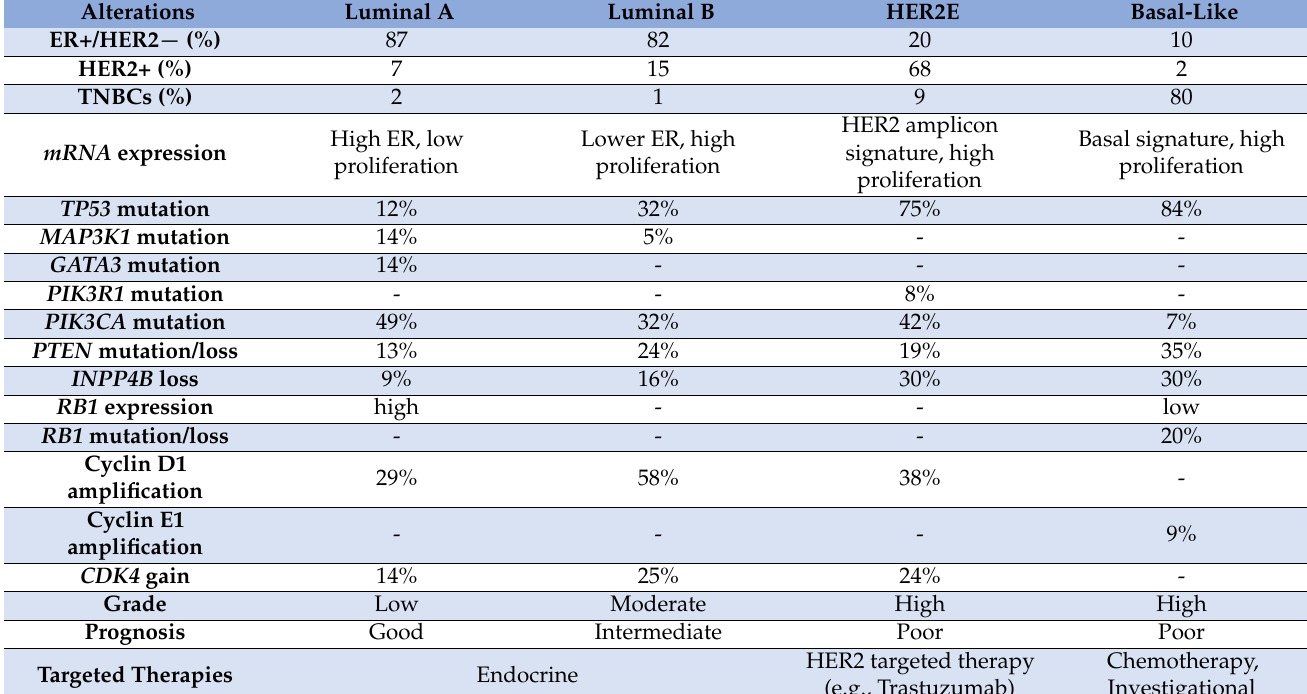
Table 1. Genomic, clinical, and pathological features of TCGA BCs classified by molecular subtypes